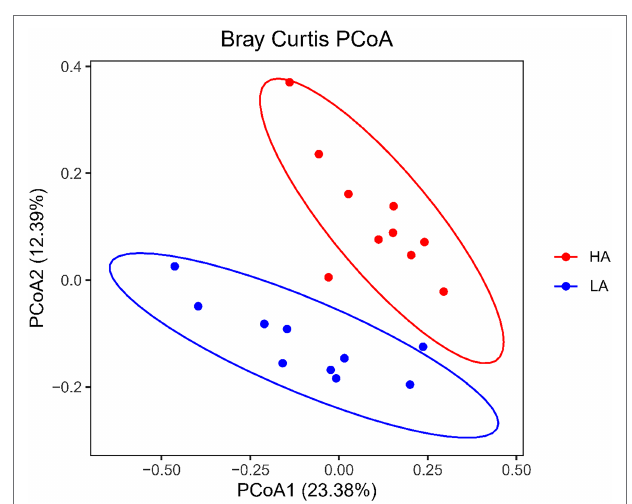
FIGURE 3 | Principal coordinates analysis (PCoA) plots of bacterial communities in Sanhe heifer rumen samples. LA, low-altitude group and HA, high-altitude